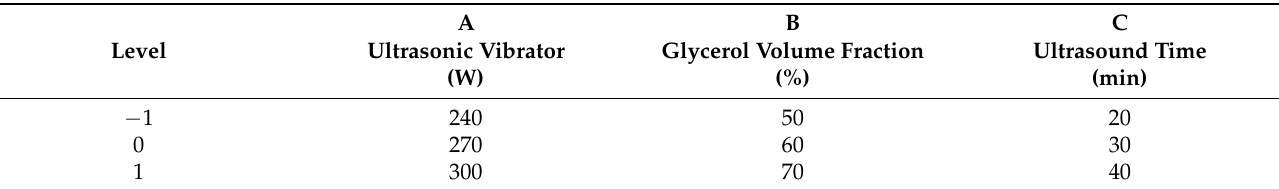
Table 3. Factors and levels in response surface design.